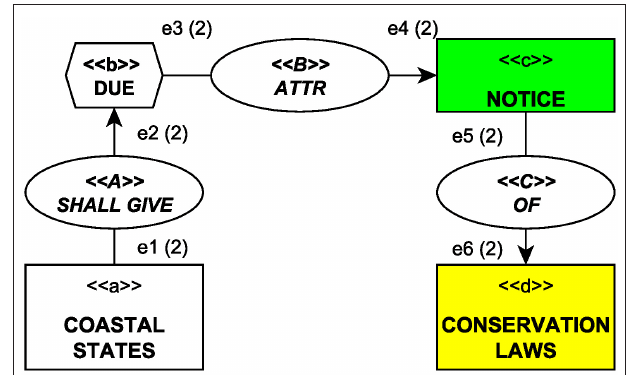
FIGURE 1 | Example of conceptual graph encoding the sentence “coastal States shall give due notice of conservation laws” (extracted from UNCLOS Art.62 § 5) with concept node set C = { a , b , c , d } , relation node set R = { A , B , C } , edge set E = { e 1,.., e 6 } , and labelling function λ ( a ) = ′ coastal states ′ λ ( b ) = ′ due ′ , ..., λ ( A ) = ′ shall give ′ , etc. The edge labels indicate their identifier and arity in parenthesis. V = { coastal states , due notice , conservation laws } (see text).